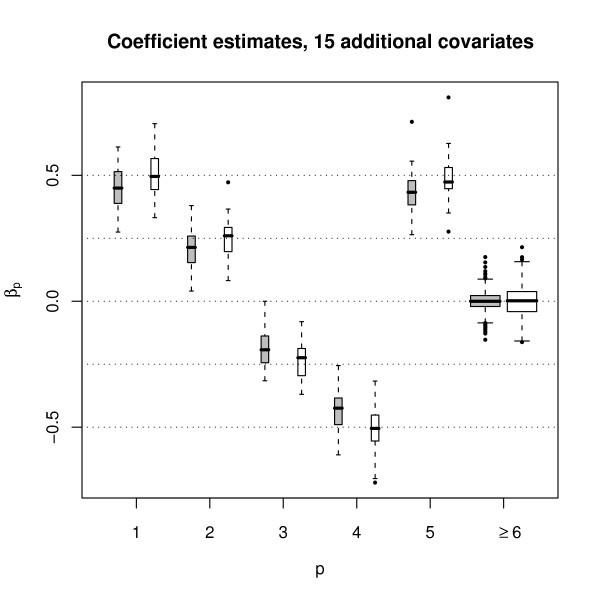
Boxplots of the Weibull parameter estimates when 5 informative and 15 additional non-informative covariates are present. Boxplots of the estimates of β1,...,β20, as obtained from the 50 Weibull-distributed samples following Model (10). Grey boxplots correspond to boosting estimates, white boxplots correspond to maximum likelihood estimates. Similar results were obtained for the log-logistic and lognormal models.